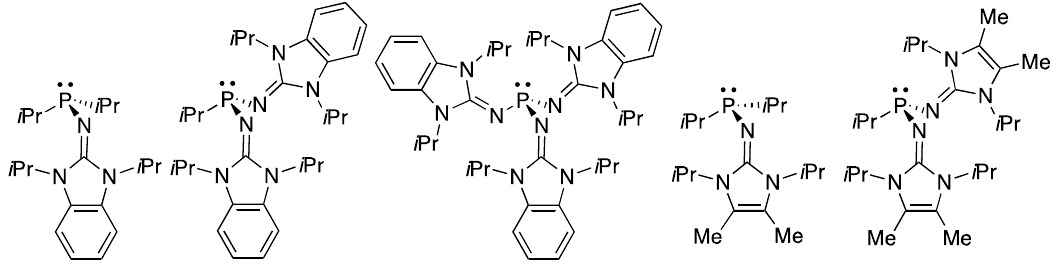
Figure 1. Imidazolin-2-ylidenamino substituted phosphines (IAPs).